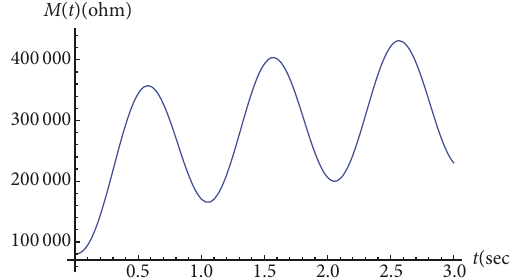
Figure 4: 𝑀(𝑡) of the fractional order memristor under the sinusoidal input with 𝐼 𝑚 = 110 𝜇 A: 𝛼 = 0.75 (red), 𝛼 = 1 (green), 𝛼 = 1.25 (blue), and HP memristor (black dots).